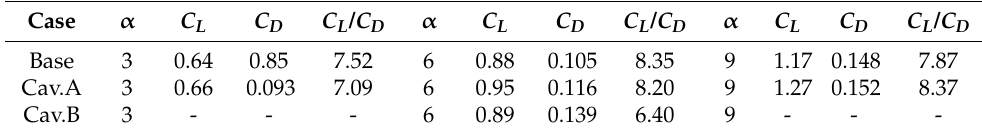
Table 4. Comparison of lift and drag coefficients for different